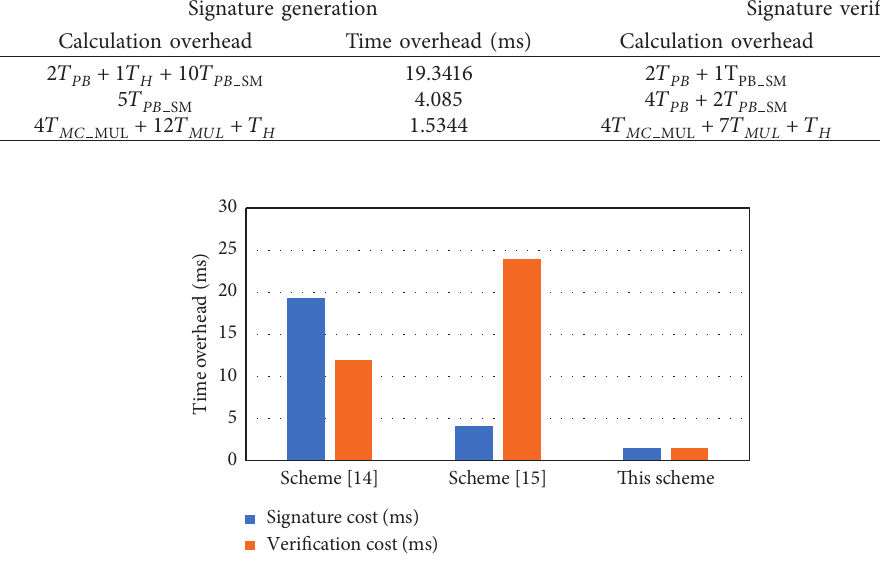
Figure 3: Comparison of signature generation and signature verification overhead.